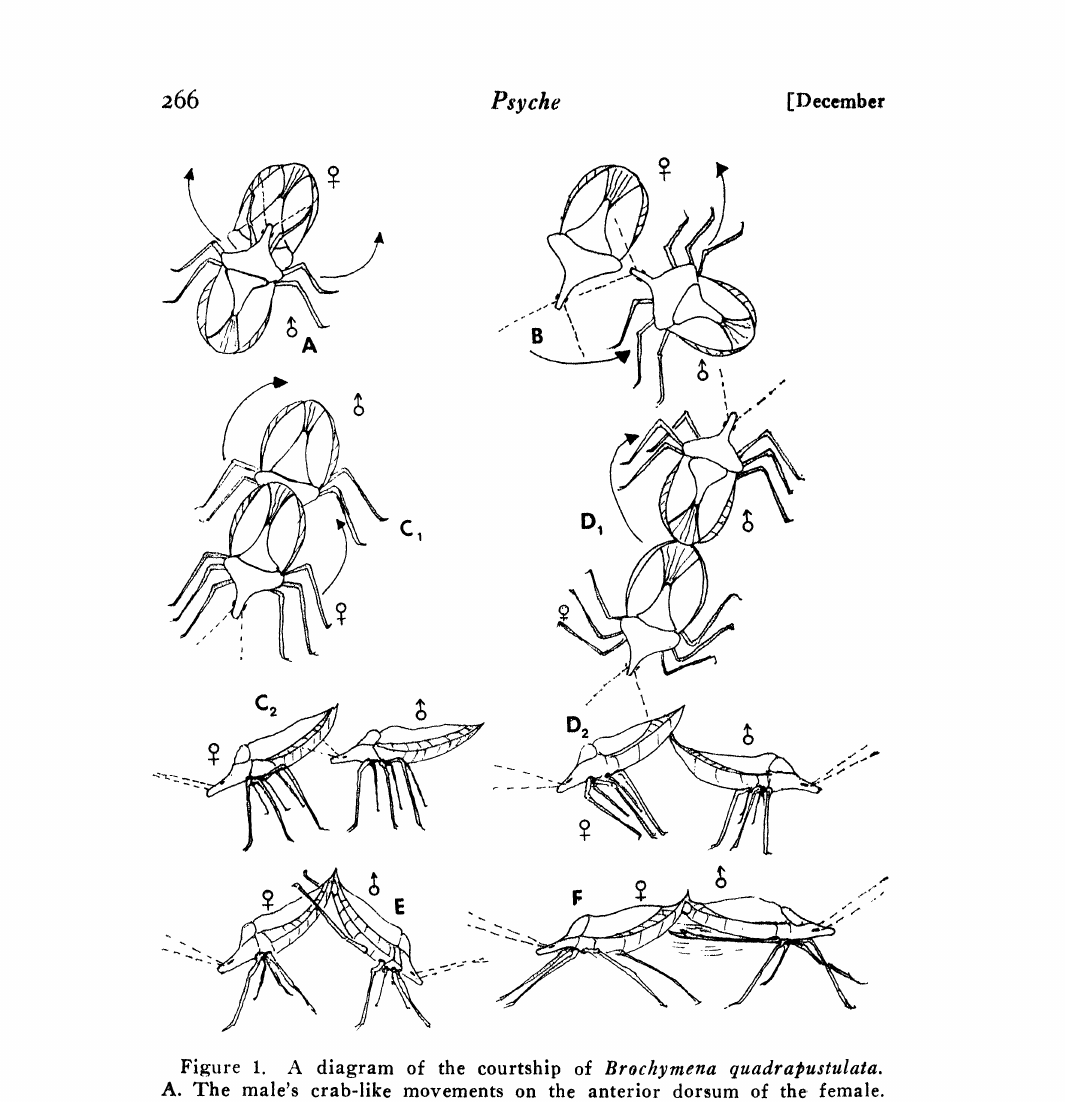
Figure 1. A diagram of the courtship of Brochymena quadralustulata. A. The male’s crab-like movements on the anterior dorsum of the, female. B. The male moves to the rear of the female. C. The view from above and from the side of the male antennating the renter of the female’s abdomen. D. The view from above and from the side of the male about to achieve genital linkage. E. Genital linkage in an end-to-end position. F. The male drumming on the side of the female with its